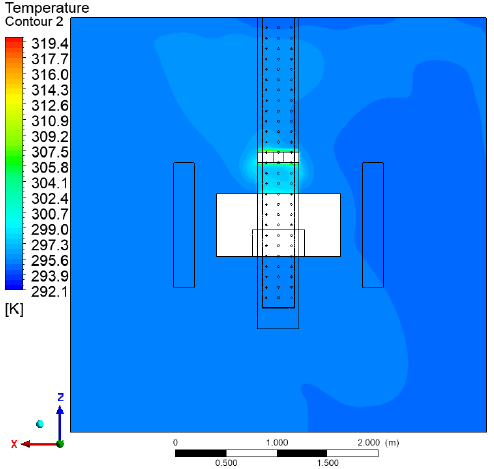
Figure 28. The temperature distribution of the Z = 2 m section.